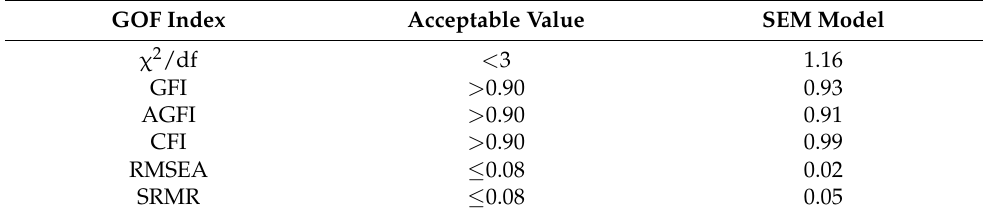
Table 4. The result of SEM goodness-of-fit statistic.